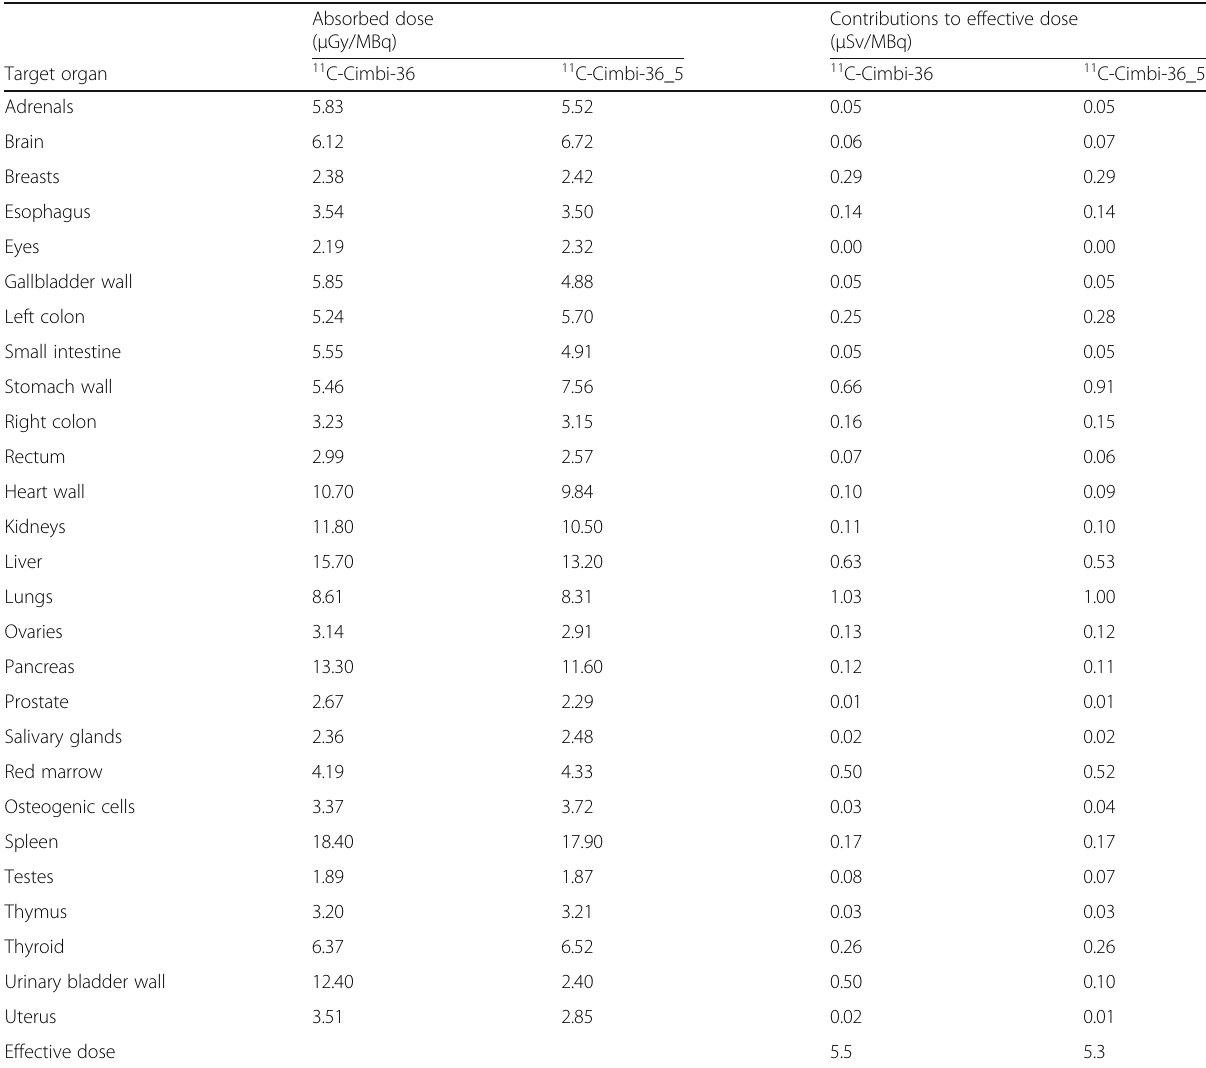
Table 1 Organ absorbed doses and contributions to effective doses for 11 C-Cimbi-36 and 11 C-Cimbi-36_5 Absorbed dose ( μ